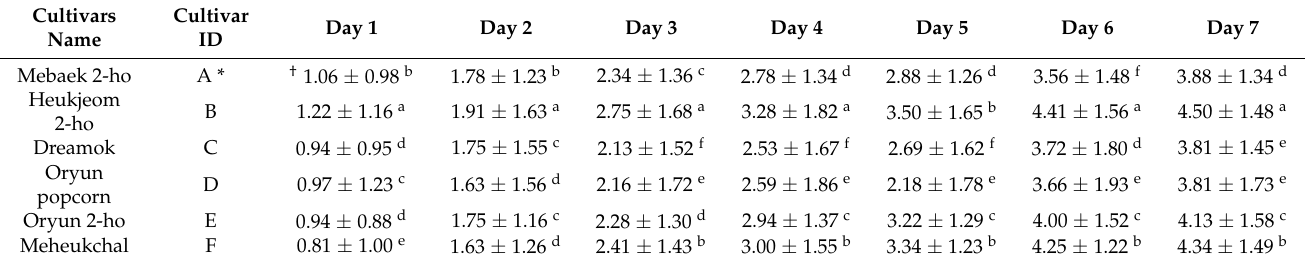
Table 2. The considered damage score based on eating ability for maize plants’ leaves and